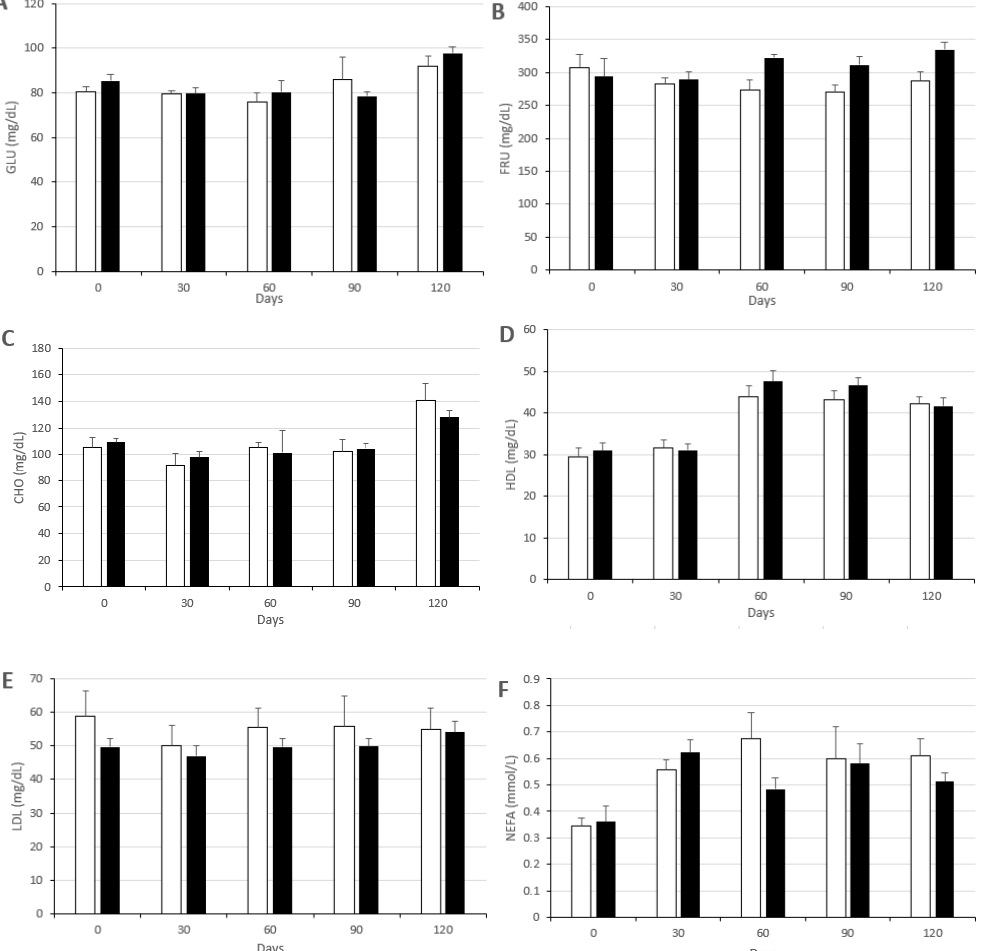
Figure 3. Mean values (± S.E.M.), over time of study, in mean plasma concentrations (± S.E.M.) for glycemic and lipidic metabolic parameters in sows used as controls (group CON; white bars) or treated with two doses of Vacsincel ® for inducing ovarian inactivity (group MEN; black bars); GLU: glucose ( A ); FRU: fructosamine ( B ); CHO: total cholesterol ( C ); HDL and LDL: high- and low-density lipoproteins cholesterol, respectively ( D and E respectively); NEFA: non-esterified fatty acids ( F ).